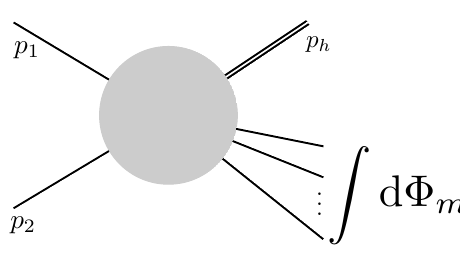
Figure 1 . Schematic depiction of a partonic scattering cross involving m +2 partons and a color neutral particle h